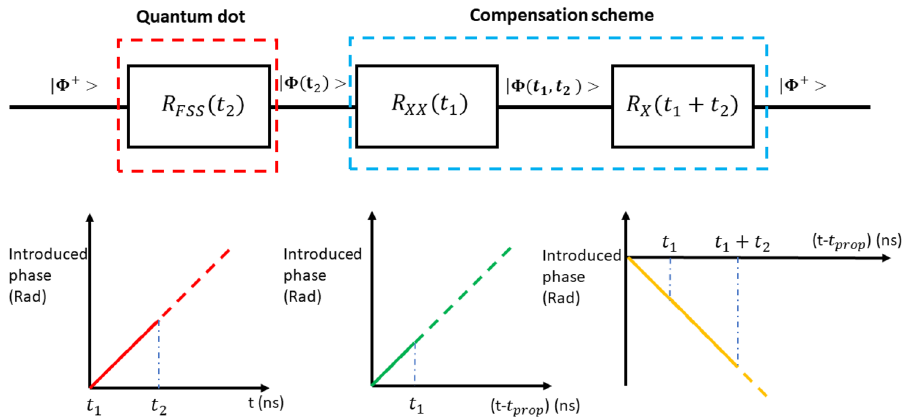
Figure 1. Circuit model representation of the overall temporally-phase evolution in the proposed compensation scheme: spin precession inside the quantum dot causes the build-up of a phase dependent on random time t 2 .After emission, the effect of the scheme on the biexitonic part of the state adds another phase jump dependent on t 1 (emission time of the biexciton photon) when the XX photon crosses the system at time t 1 t prop . Both phase terms are compensated by the operation of the excitonic part of the wavefunction, if the − proper conditions are met, when the exciton photon is imparted an opposite phase at time t 1 t X t XX t X that we have assumed t XX prop start for start = prop = =